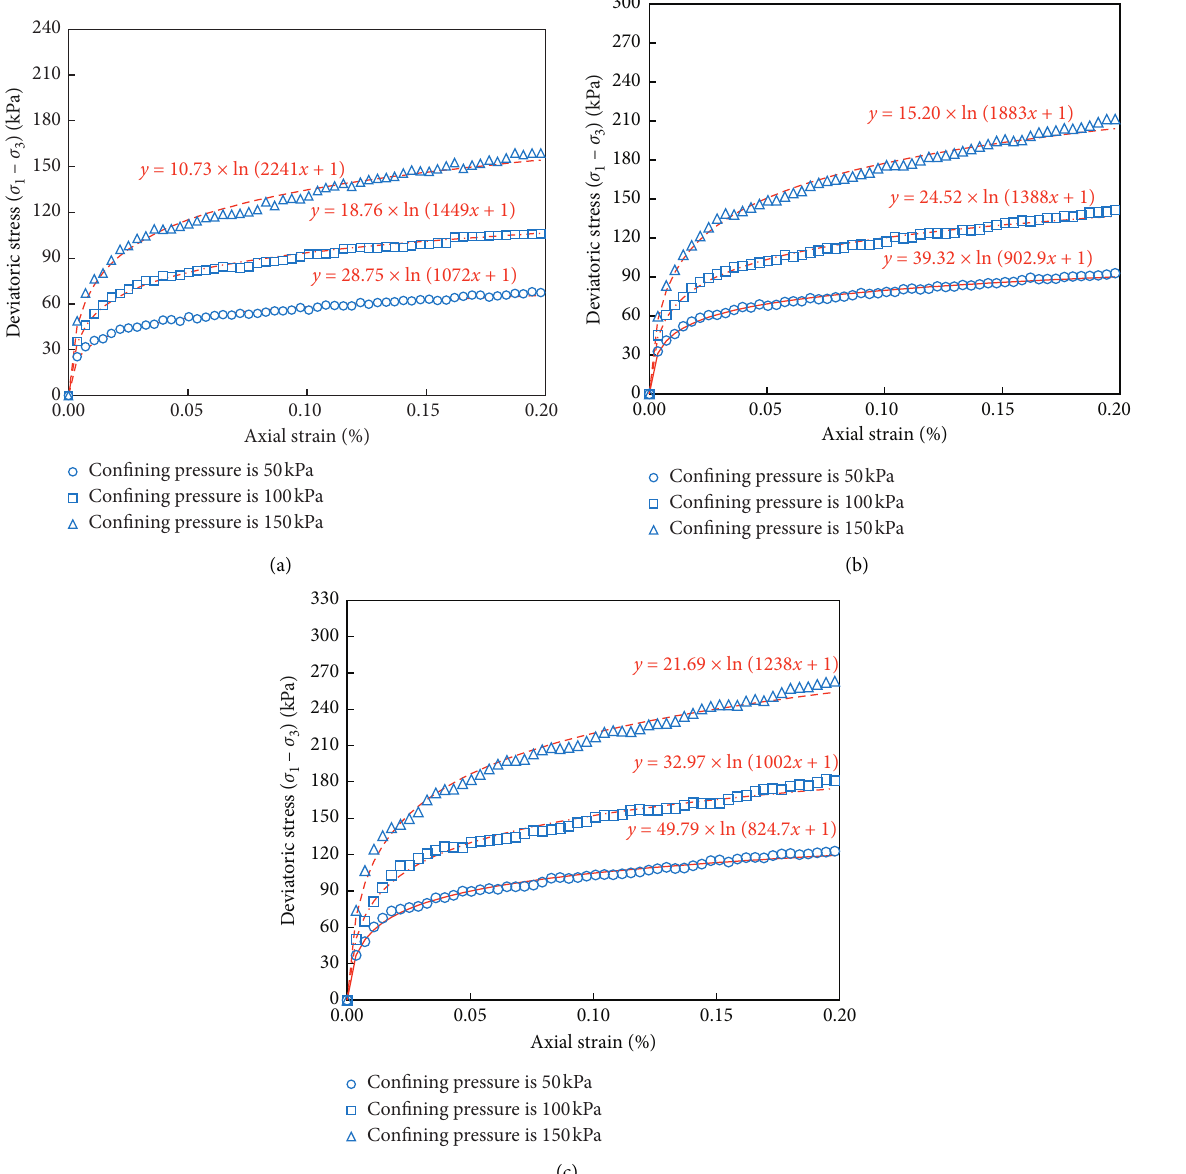
Figure 3: Relationship between deviatoric stress and axial strain: (a) degree of compaction is 90%; (b) degree of compaction is 93%; (c) degree of compaction is 96%.